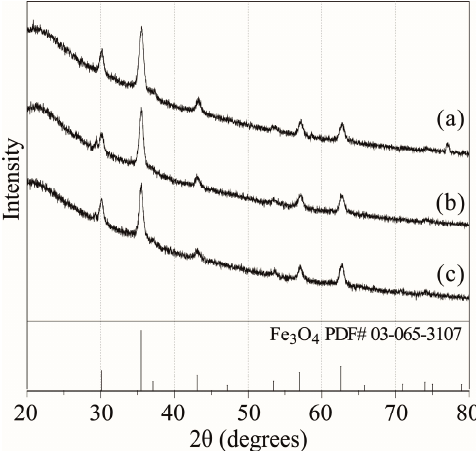
Figure 5. XRD patterns of ( a ) 6.6 ± 1.0 nm (1 h); ( b ) 13.0 ± 0.9 nm (3 h);